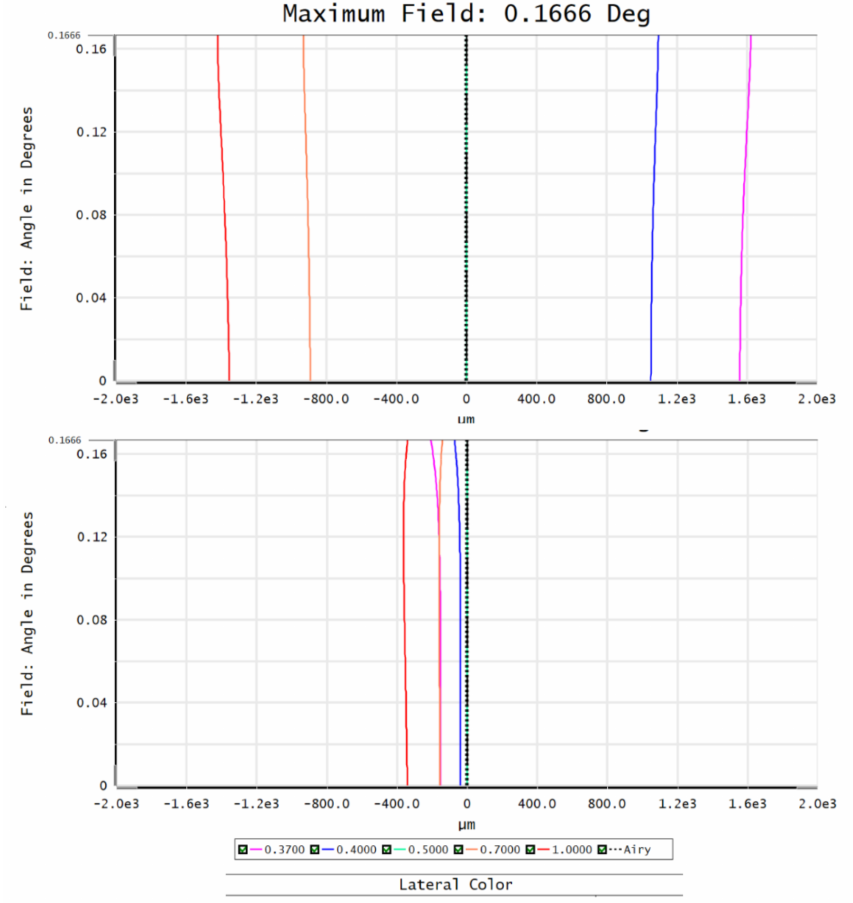
Figure 4. ( Top ) Modelled atmospheric dispersion lateral at the GMT site in Chile for a zenith distance of 60 degrees. ( Bottom ) Residual secondary spectrum after C-ADC correction. The horizontal scale in microns is also very close to the exact value for the angular lateral colour in